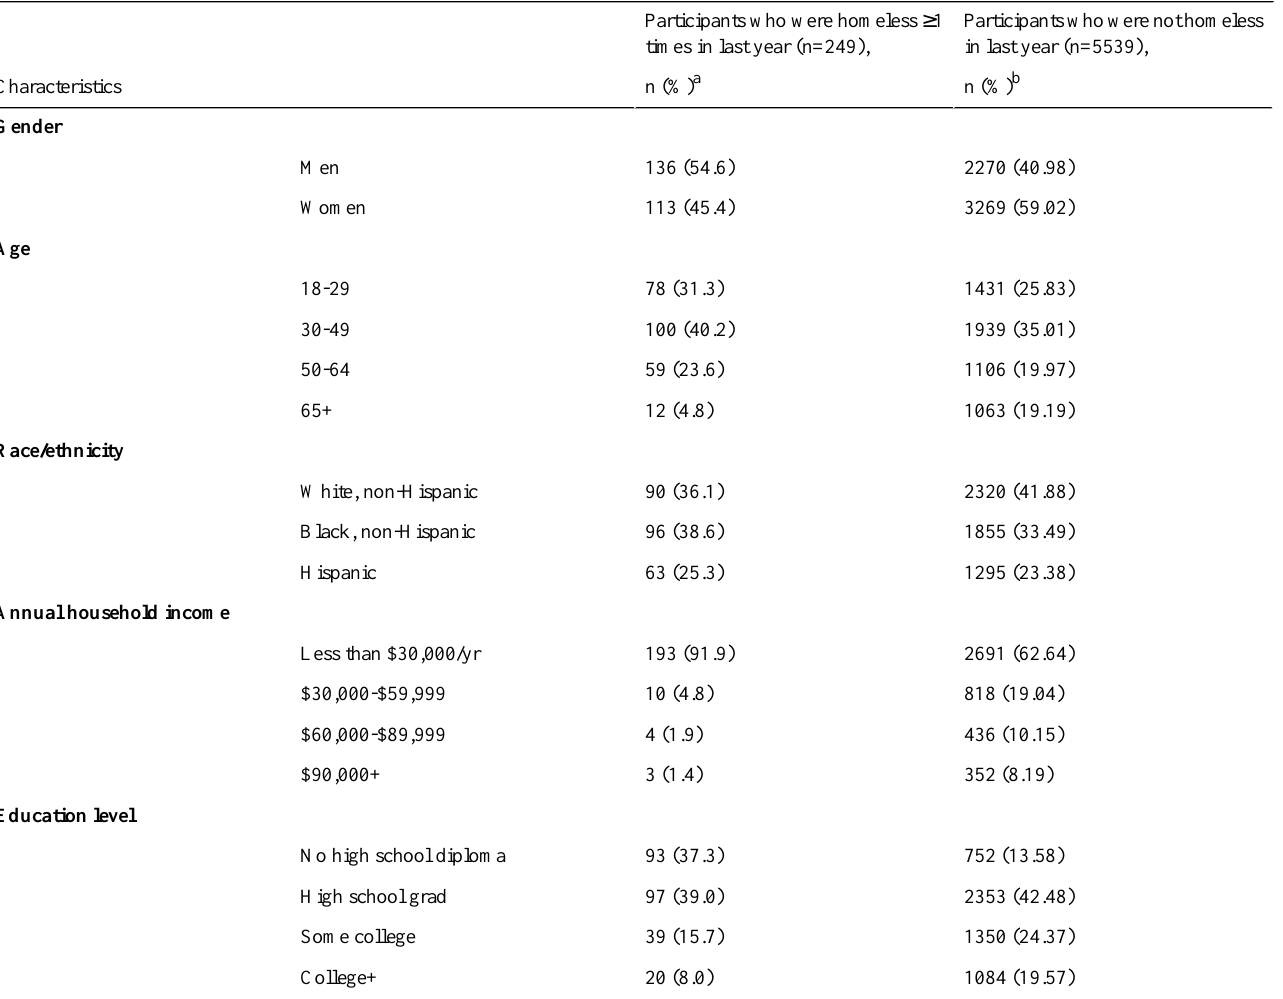
Table 1. Demographics—Emergency Department Media Study, July 12-August 30,